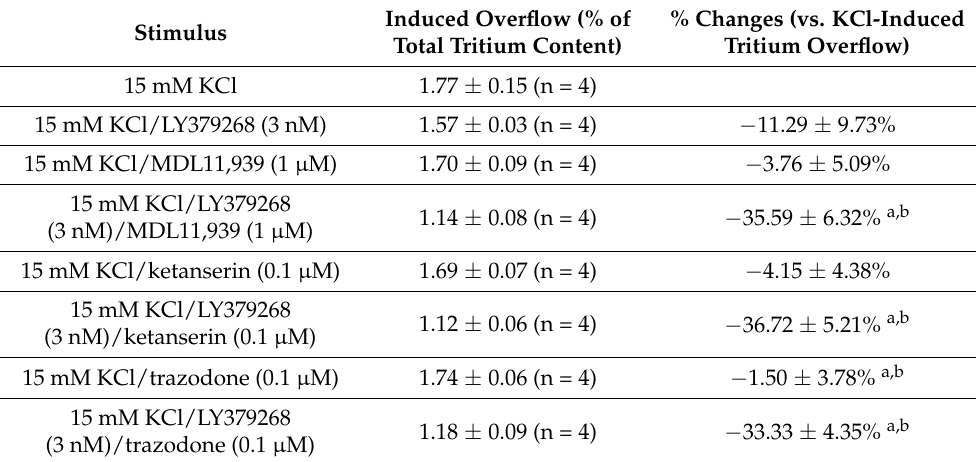
Table 2. Effects of 5-HT 2A antagonists on the release of [ 3 H]D-aspartate elicited by 15 mM KCl in the presence of nanomolar concentration of